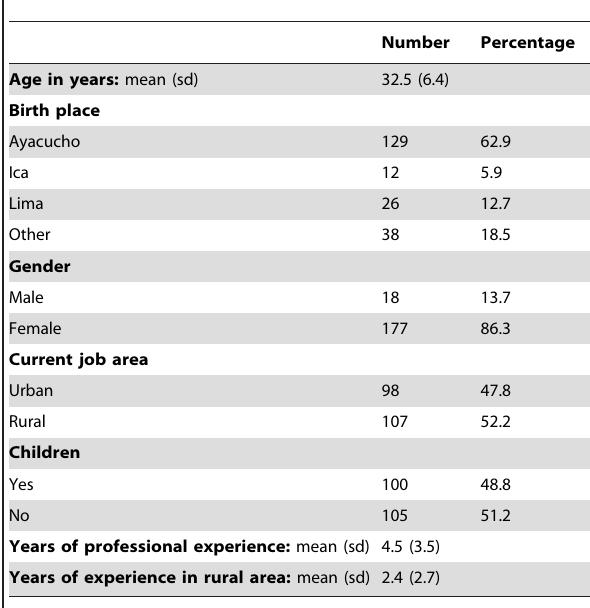
Table 3. Basic sociodemographic characteristics of